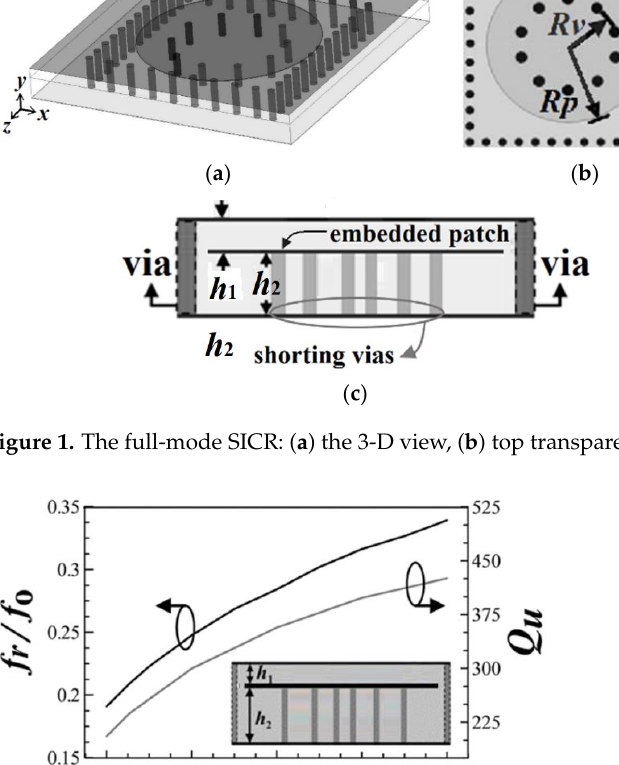
Figure 2. The simulated curves of normalized resonance frequency f r / f 0 and Q u vs. the top substrate thickness h 1 (with fixed h 2 = 1.58 mm).